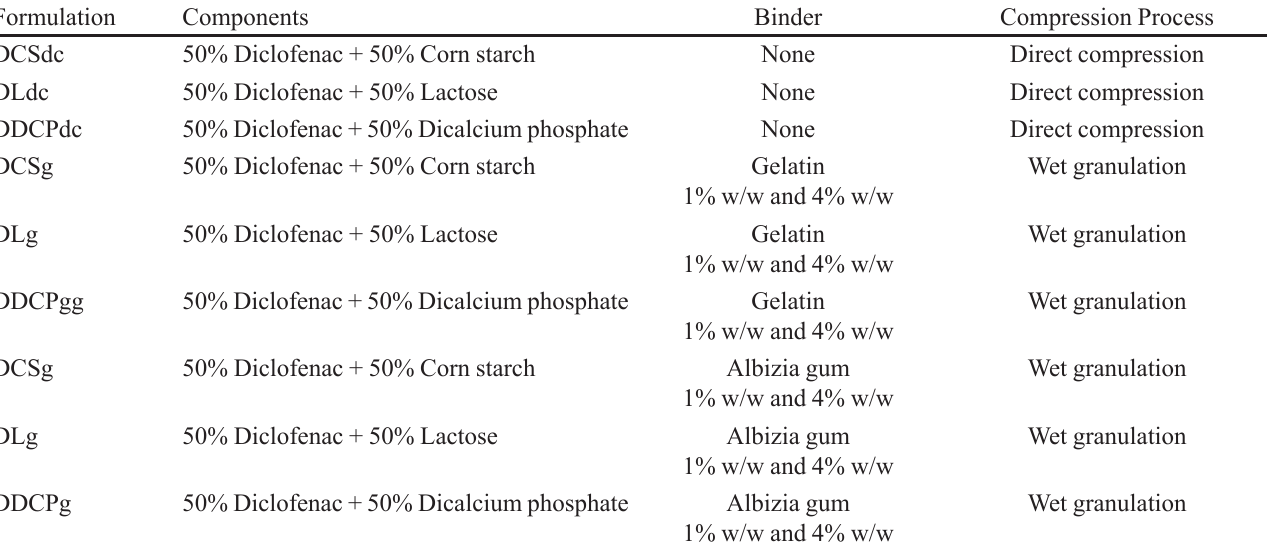
TABLE I - Formulation components and process parameters for diclofenac tablets